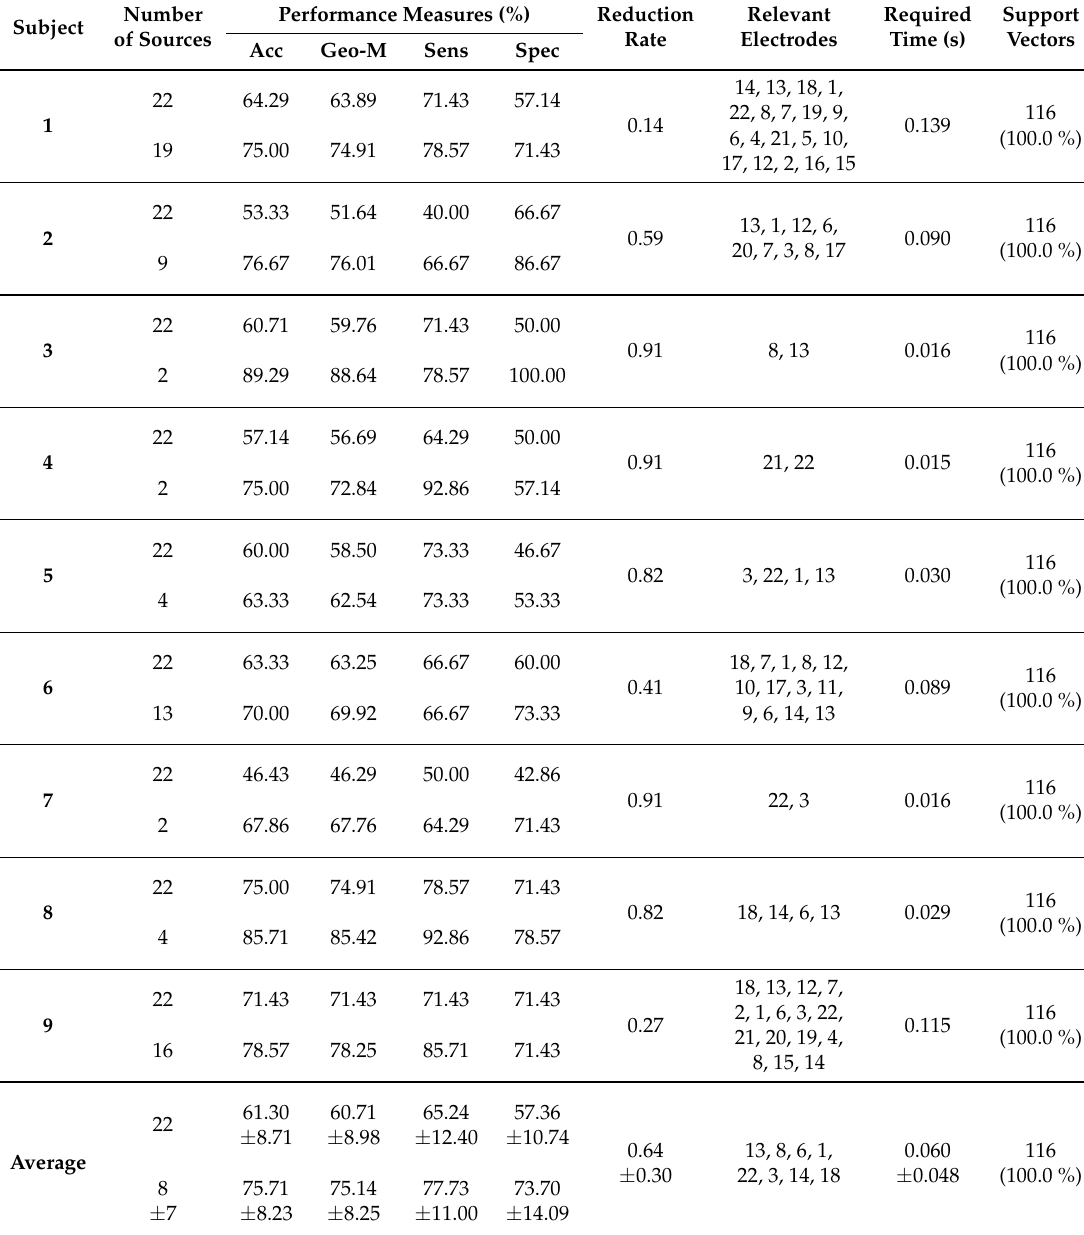
Table 1. Results of selection of BCI channels applying the Algorithm 1 and (cid:96) 2